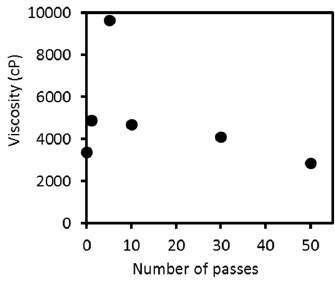
Figure 4. Viscosity of protein/CaCO 3 /chitin nanofiber dispersions as a function of the number of passes.